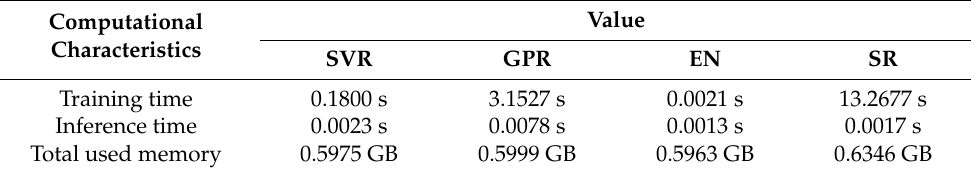
Table 4. The computational characteristics for the SR